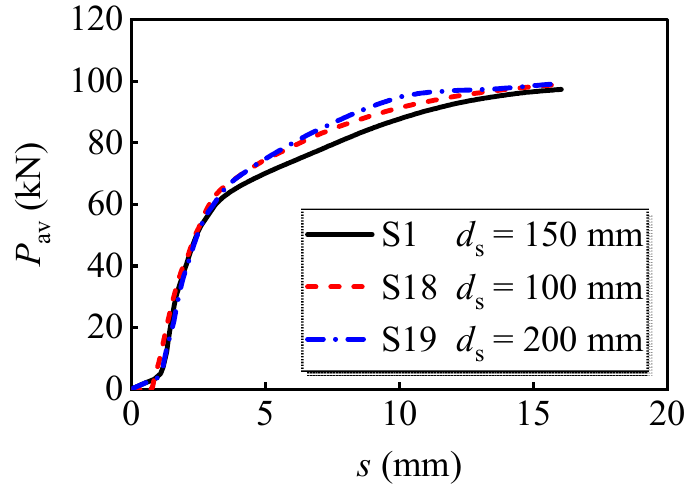
Figure 17. Average load versus slip curves for models with different slab depths.